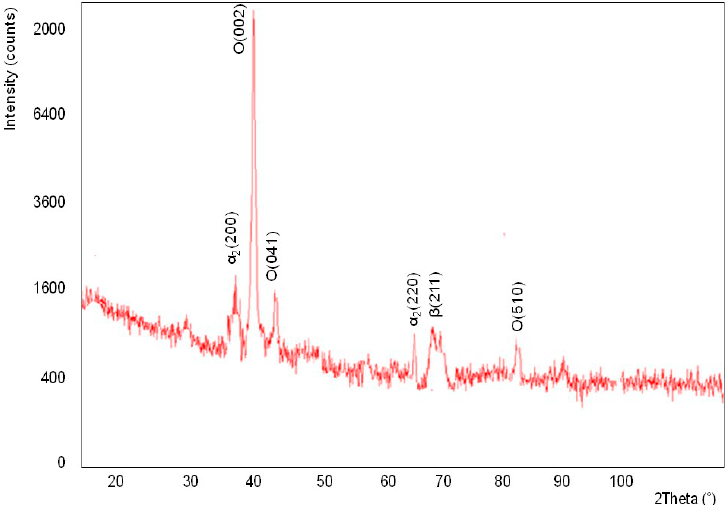
Figure 5. XRD analysis result of tested alloy.